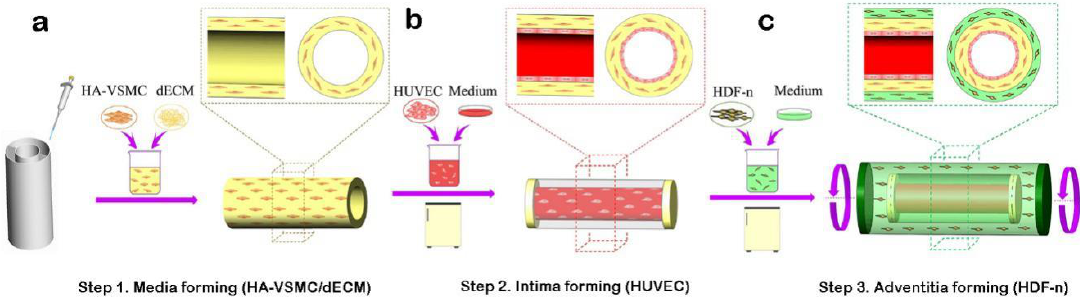
Figure 1. Schematic illustration of the fabrication process of three-dimensional (3D) arteriovenous structures with three layers: intima, media, and adventitia. ( a ) Addition of the decellularized extracellular matrix (dECM) with human aortic vascular smooth muscle cells (HA-VSMCs) between the inner layer and outer layer of the support structure. ( b ) A human umbilical vein endothelial cells (HUVEC) suspension (5 × 10 6 cells mL − 1 ) was injected into hollow channels via a pipette. ( c ) Construction of the adventitia layer by immersing the structure into a human dermal fibroblasts–neonatal (HDF-n) suspension (5 × 10 6 cells mL − 1 ) on the basis of the first two layers.